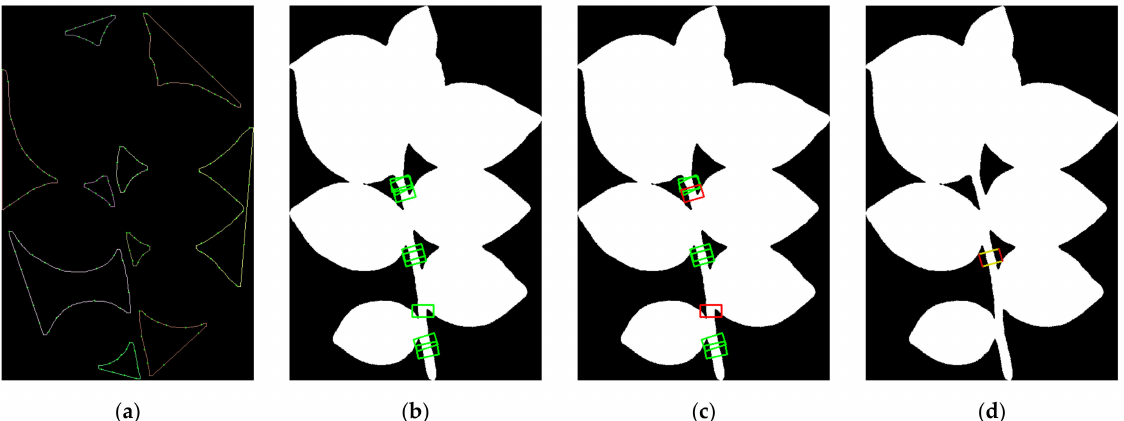
Figure 8. Key intermediate results of the grasp proposal and optimal grasp detection pipeline. ( a ) All grasp proposals are marked as green points on the boundaries of ROIs. In principle, any pair of the points from two separate RoIs is a proposed grasp ( b ) Grasp proposal after filtering out the most likely unstable grasps. ( c ) Refined proposed grasps. Grasps marked with red rectangles are excluded due to overlap with leaves as determined by high OGI. ( d ) Local optimal grasp, which has the smallest